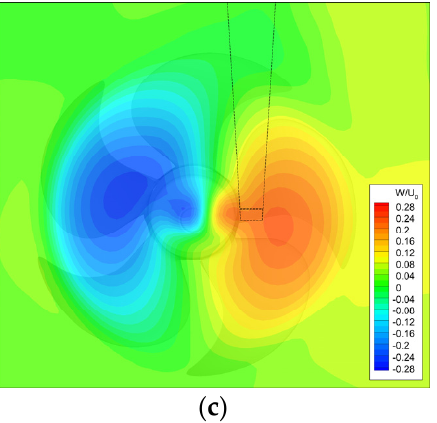
Figure 12. Velocity distribution of rudder inflow obtained from numerical calculation. ( a ) U (X-direction), ( b ) V (Y-direction), and ( c ) W (Z-direction).